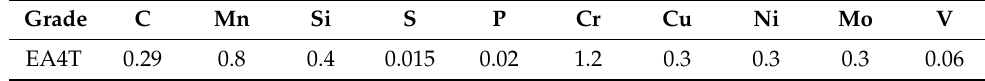
Table 1. Chemical composition of EA4T steel [19].